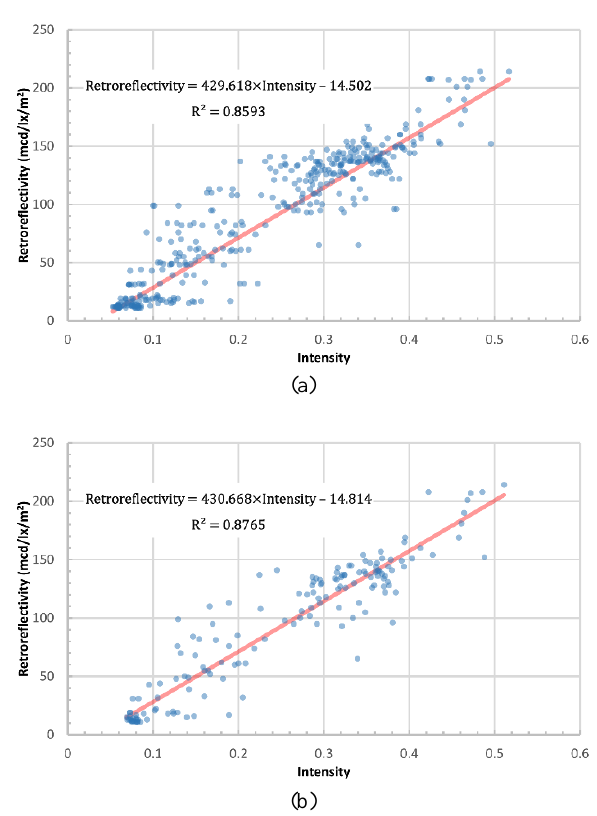
Figure 7. Linear regression results using (a) points from each single scan within the passive window treated separately; (b) average of points from all the scans combined within the passive window.